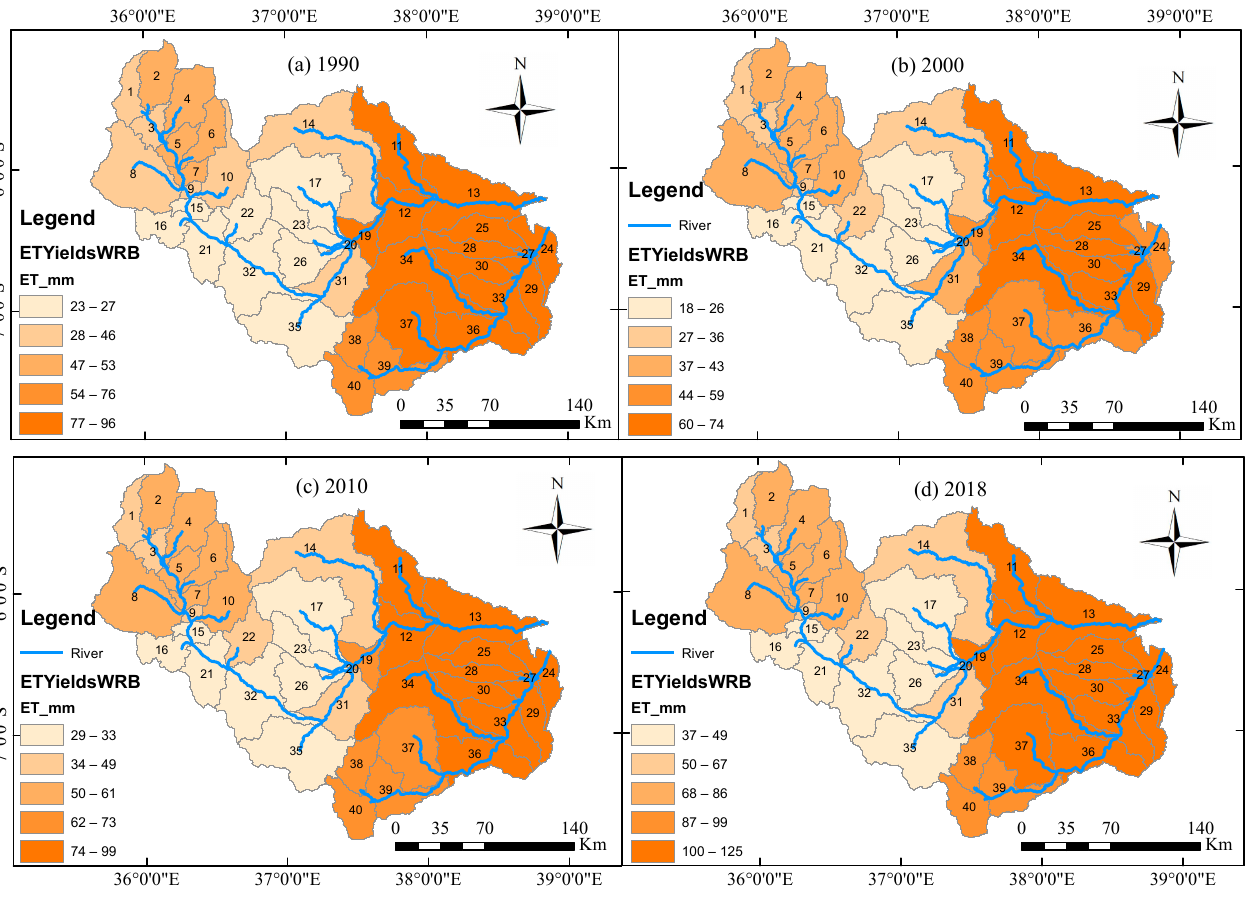
Figure 11. The simulated spatial pattern of ET in the WRB for the years ( a ) 1990, ( b ) 2000, ( c ) 2010, and ( d ) 2018.